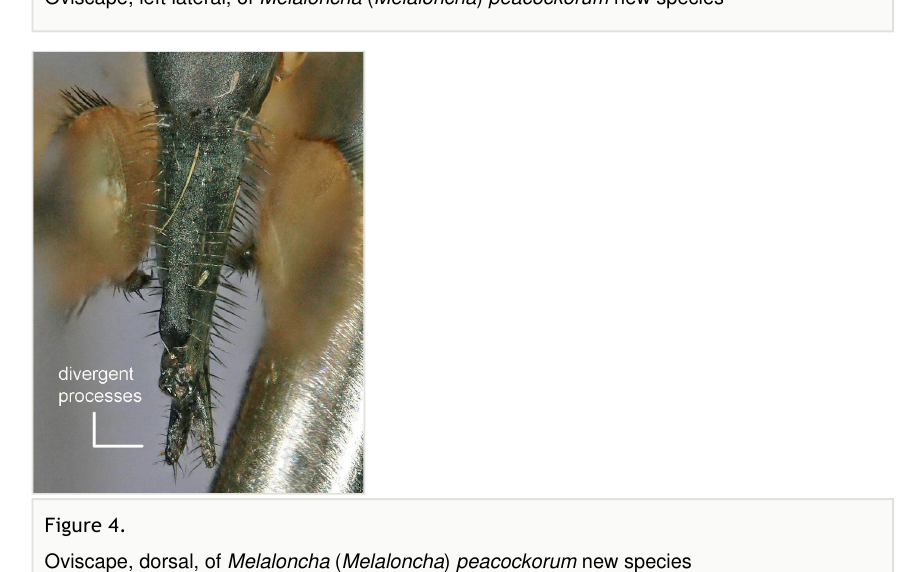
Figure 3. Oviscape, left lateral, of Melaloncha ( Melaloncha ) peacockorum new species